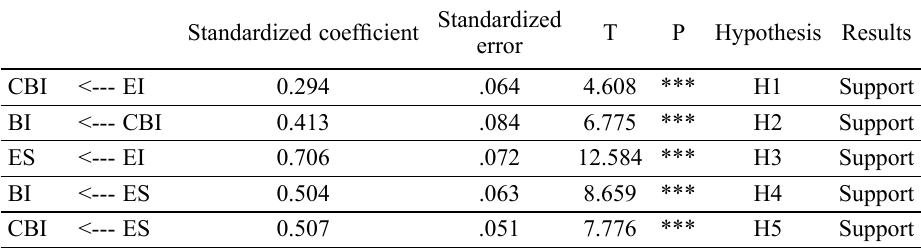
Table 3. Results of hypotheses